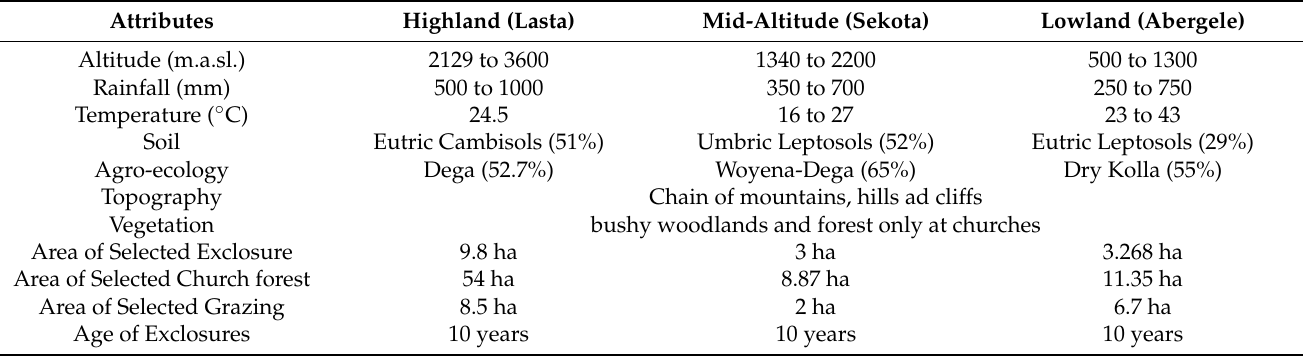
Figure 1. Map of the study area. Table 1. C haracteristics of the study area .